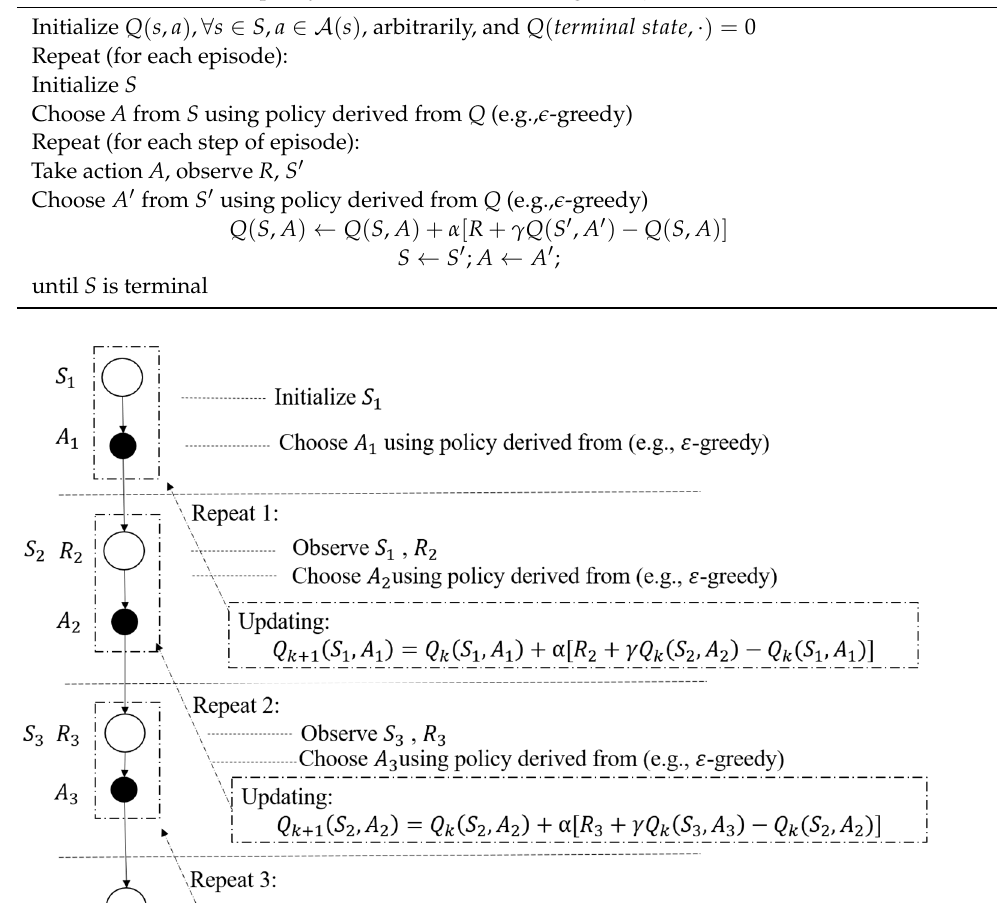
Algorithm 2 Sarsa (on-policy TD control) for estimating Q ≈ q ∗